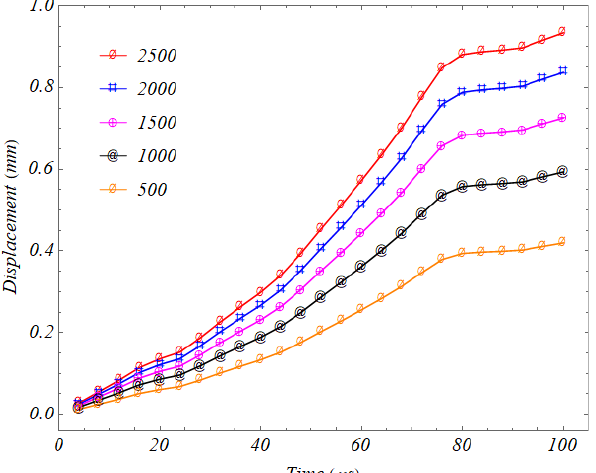
Fig. 33. Displacement against time for various drop distances with a single cell phone